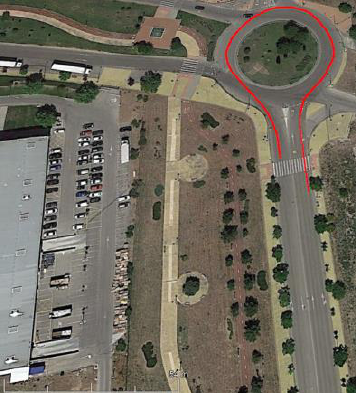
Figure 5. Test 1: Map and vehicle trajectory (Map scale 1:2100 cm).